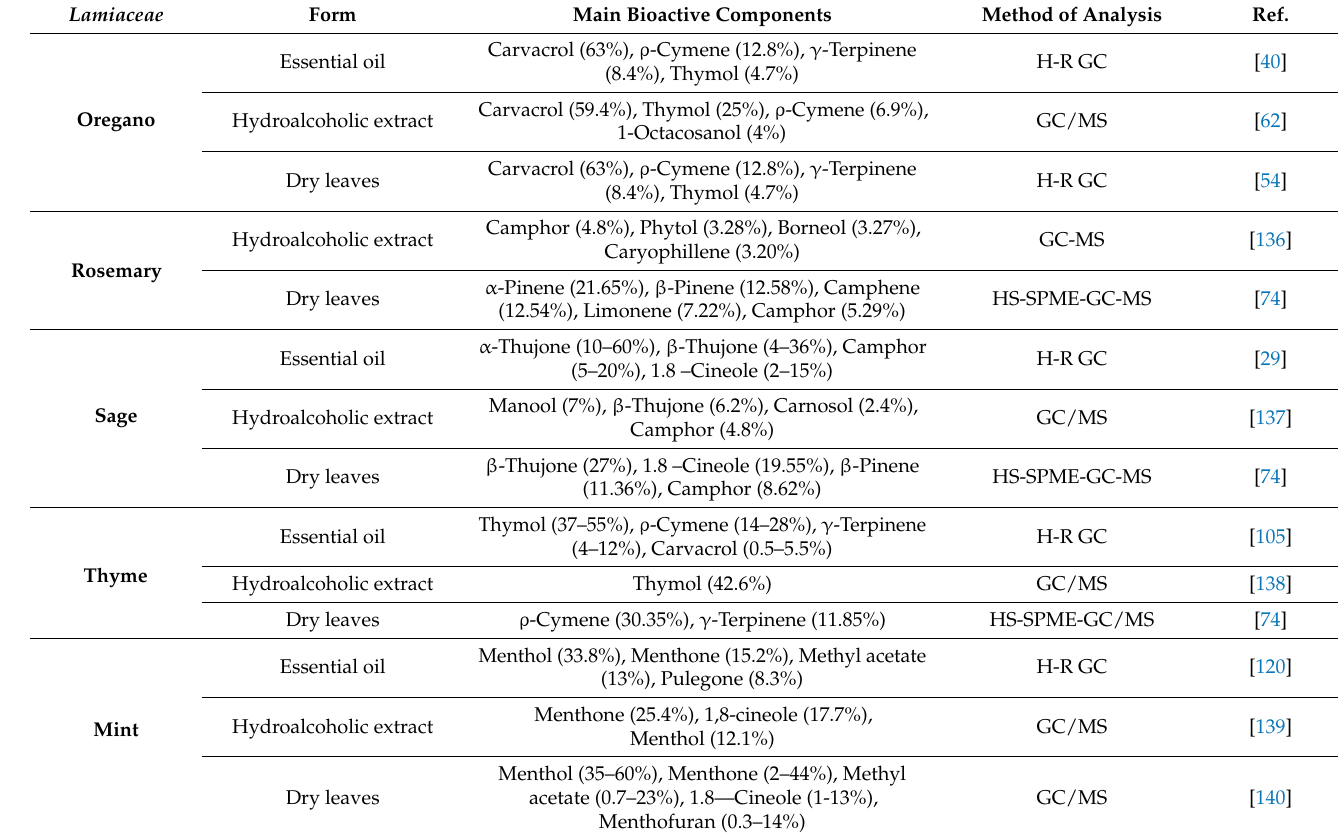
Table 6. The major bioactive compounds identified in essential oil, hydrolcoholic extract and leaves of Lamiaceae plants (oregano, rosemary, sage, thyme and